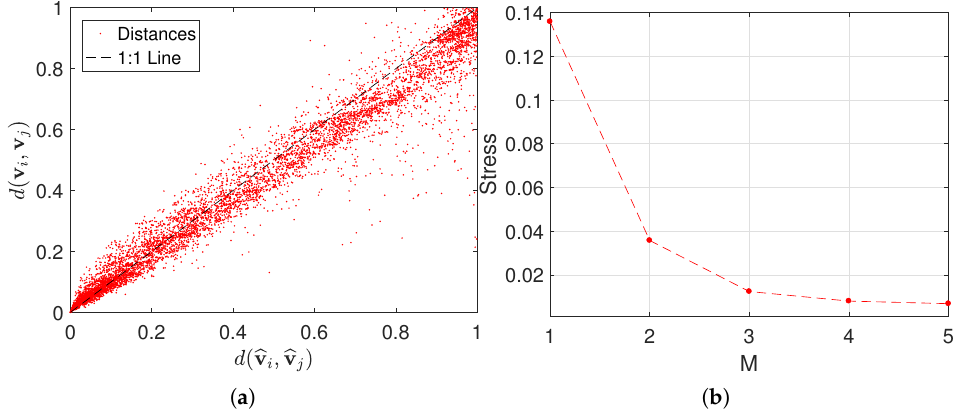
Figure 6. The MDS assessment charts for the Jaccard distance, d 6 : ( a ) Shepard; ( b )